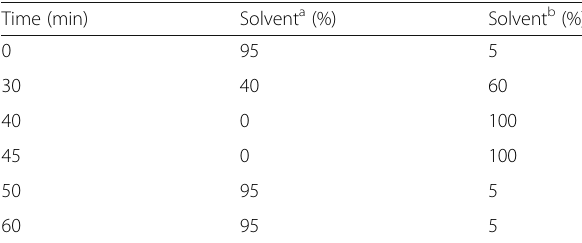
Table 2 Composition of mobile phase for chromatographic